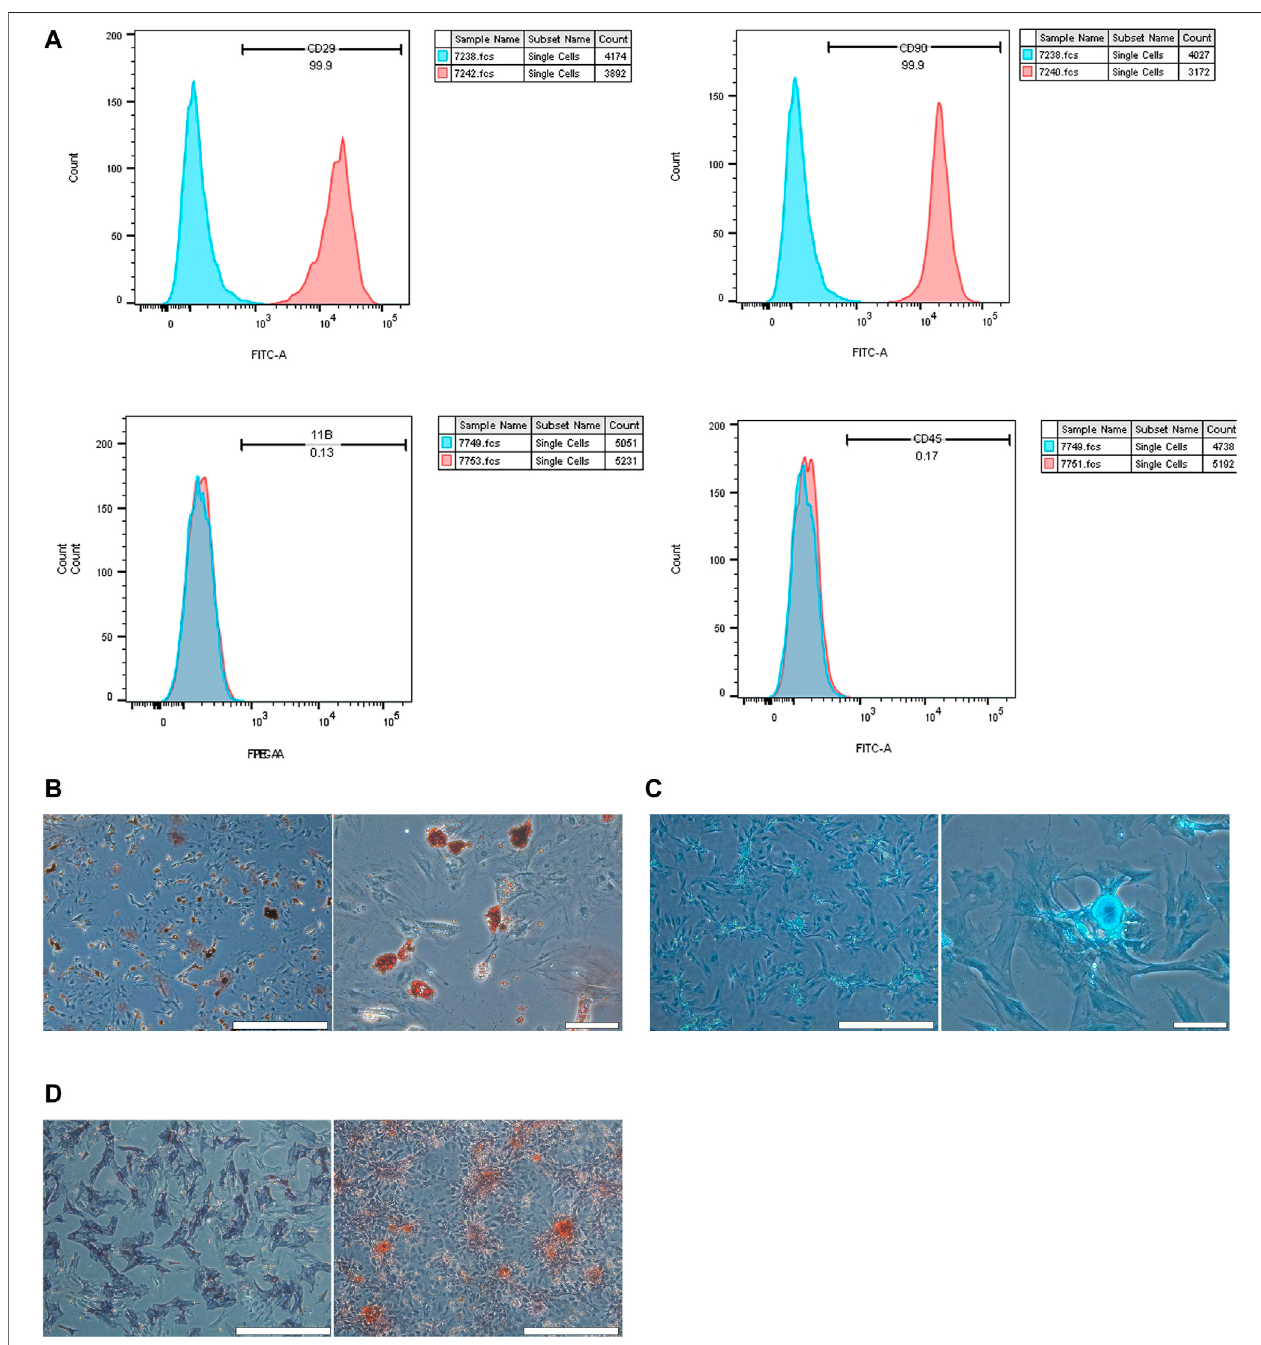
FIGURE 2 | Validation of BMSCs. (A) fl ow cytometry was used to con fi rm the characterization of BMSCs. BMSCs expressed CD90 and CD29, but they did not express CD45 and CD11b/c. (B) Adipogenic differentiation was identi fi ed by Oil Red O staining at low and high magni fi cation. (C) Chondrogenic differentiation was assessed by chondroblast staining at low and high magni fi cation. (D) Osteogenic differentiation was evaluated by ALP staining and ARS staining at low magni fi cation (scale bar (cid:1) 200 µm).